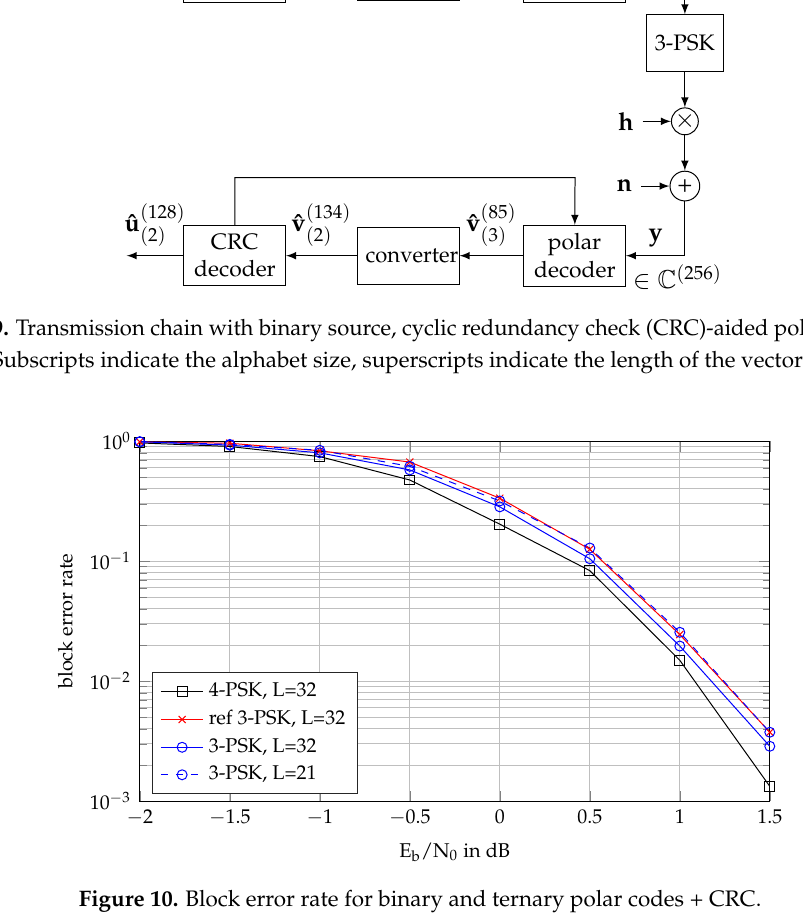
Figure 10. Block error rate for binary and ternary polar codes +